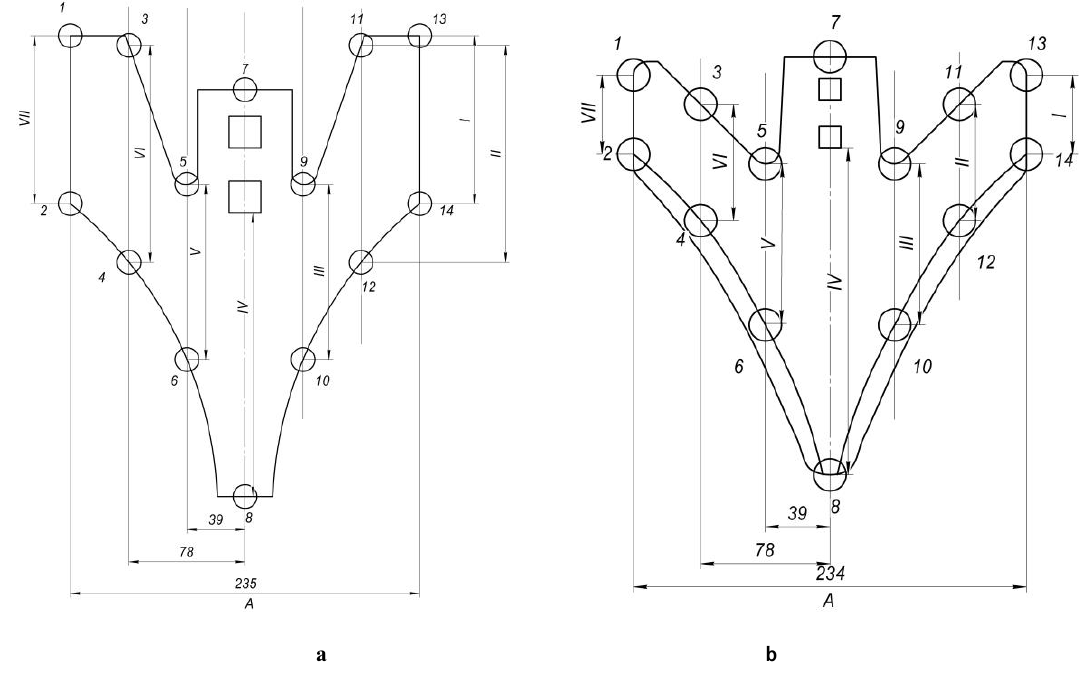
Fig. 3. Measurement of thickness and linear dimensions on new (a) and worn out (b) cultivator blades of MARATHON SERIES and TM II